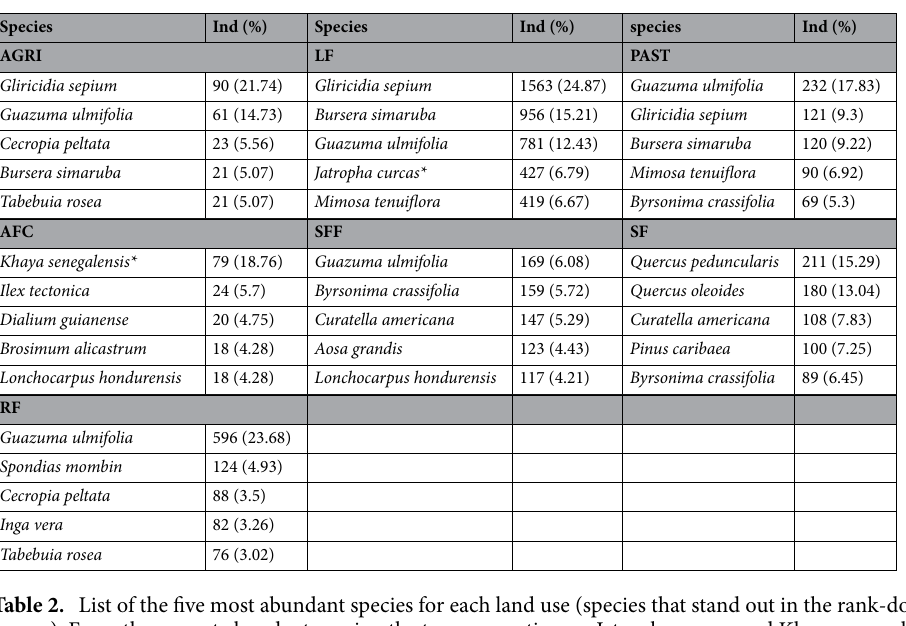
Table 2. List of the five most abundant species for each land use (species that stand out in the rank-dominance curves). From these most abundant species, the two non-native are Jatropha curcas and Khaya senegalensis. The different land uses are secondary forest (SF), secondary forest fragment (SFF), agroforestry coffee (AFC), agriculture (AGRI) and pastures (PAST), live fences (LF) and riparian forest (RF).